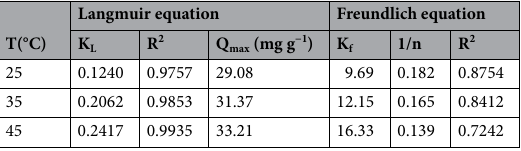
Table 2. Parameters of Langmuir and Freundlich equations of BMBC adsorption of Cr(VI).